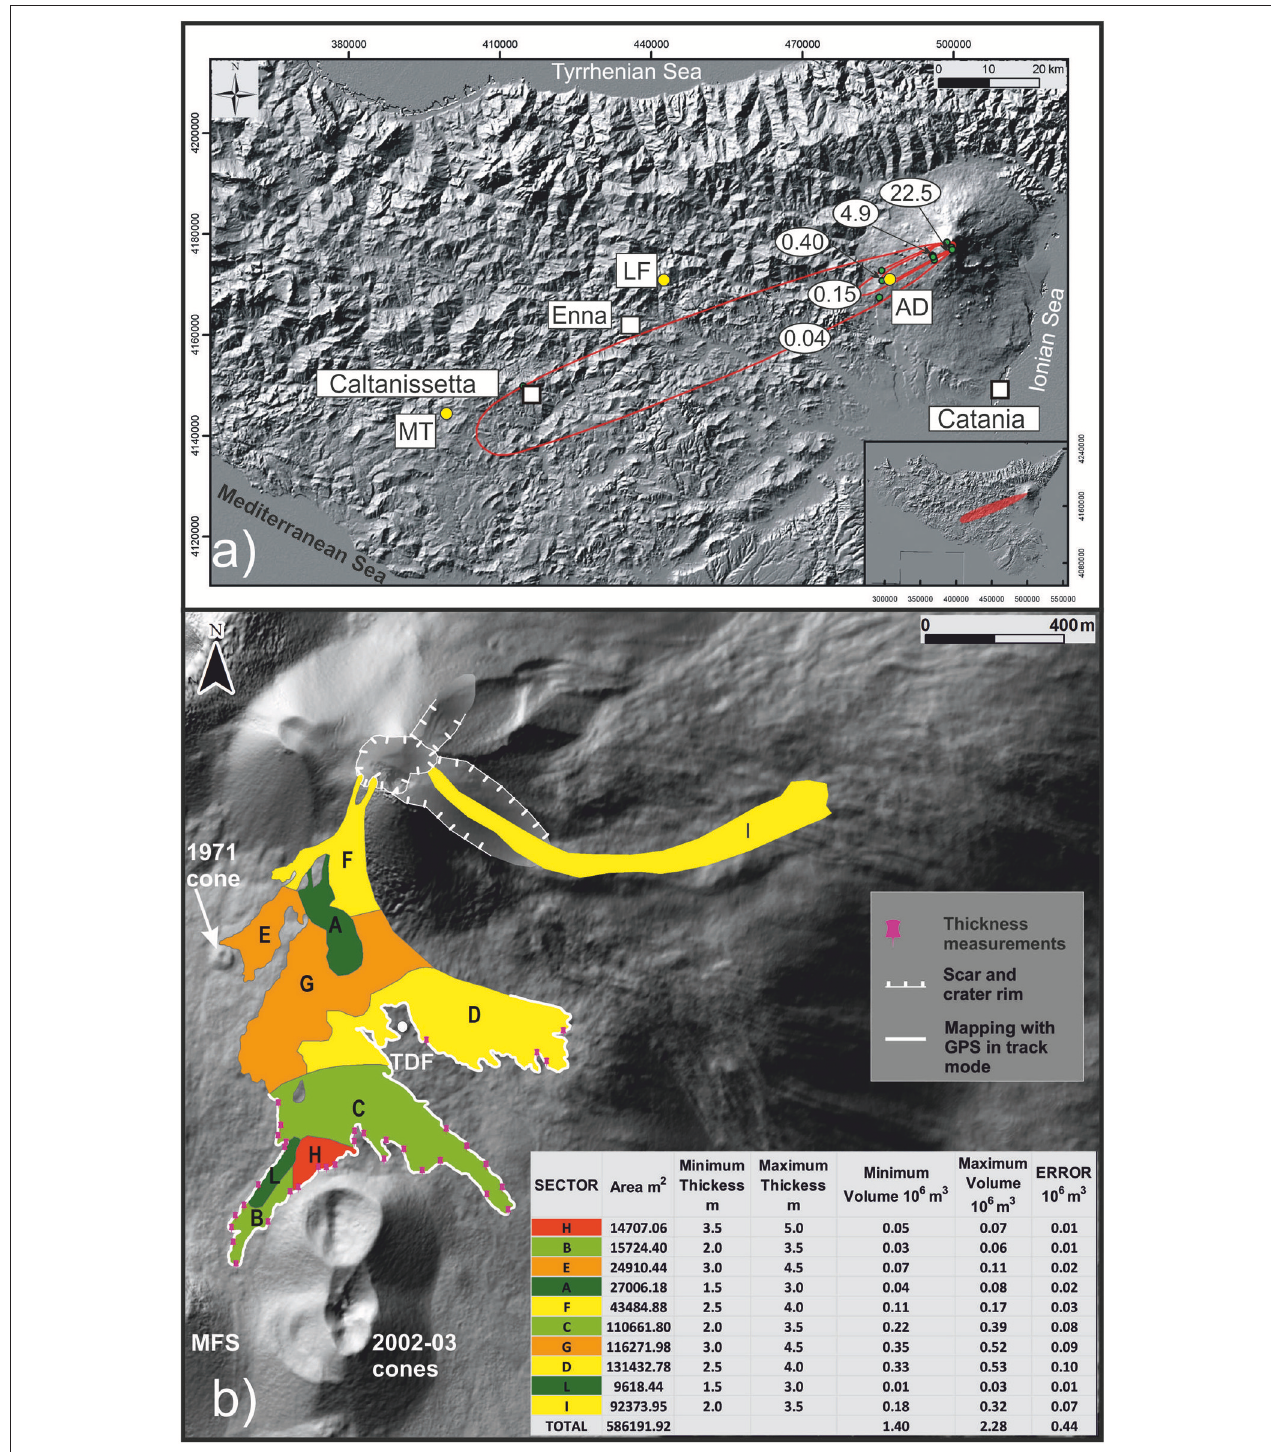
FIGURE 7 | Mapping of the volcanic deposits erupted during the 25-26 lava fountain 2013 episode. (a) Tephra fallout on the shaded relief of Sicily; the red lines are the isomasses in kg per square meter (values in full white circles). Full white squares are the main cities in this part of Sicily (Catania, Enna e Caltanissetta). Full yellow circles indicate some localities affected by the fallout (AD, Adrano; LF, Leonforte; MT, Montedoro). The bottom right inset shows the fallout deposit drawn over the map showing all of Sicily. (b) The NSEC cone and the associated lava flows on the shaded relief of Mount Etna volcano. TDF is the location of a former alpine shelter buried under recent tephra and lava, MFS is Monte Frumento